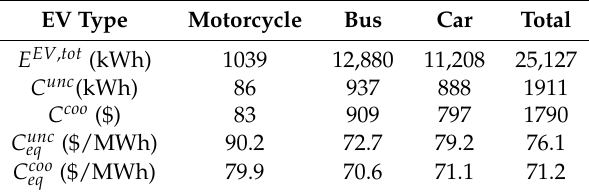
Figure 9. Diesel generation and RES power excess consumed by EVs for Scenario 9. Table 5. Energy and Costs for each type of EV for Scenario 9.